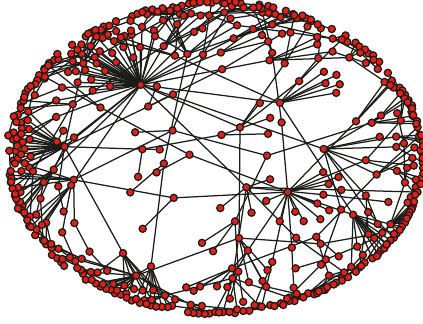
Figure 4: Coupling coefficient matrix 𝑀 BA .